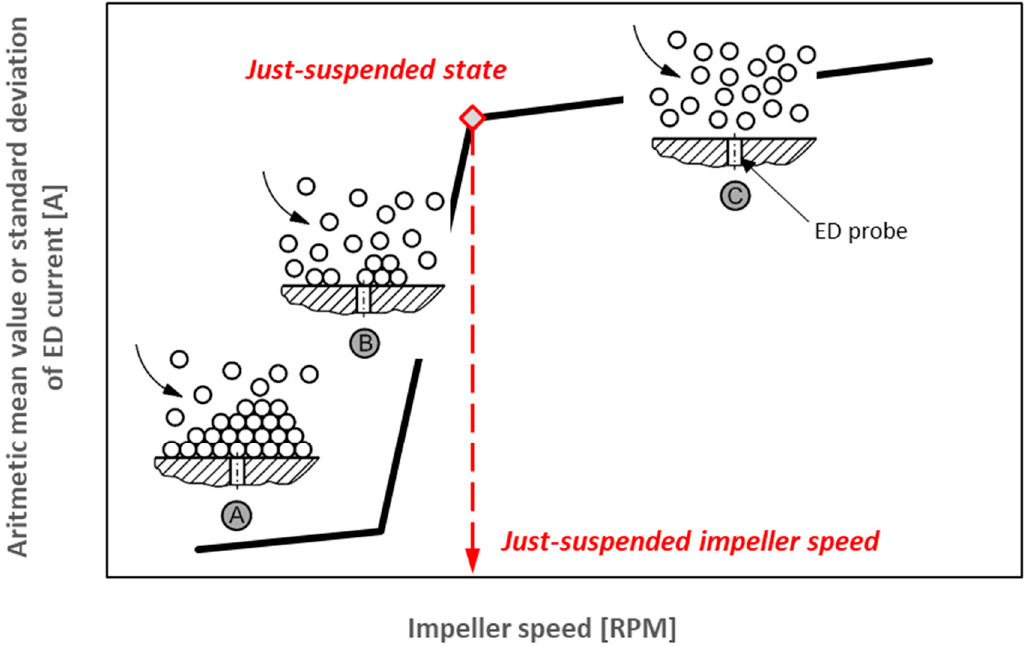
Figure 4. Typical dependence of the measured electrodiffusion (ED) probe electric current on the agitator speed with the representation of the typical states of particles behavior in the suspension at the vessel bottom [10].